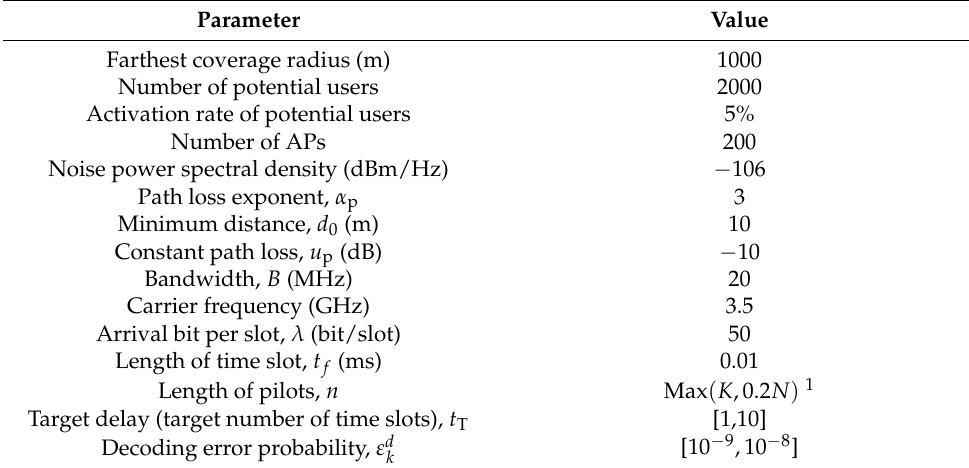
Table 1. Parameters Values for Numerical Results.